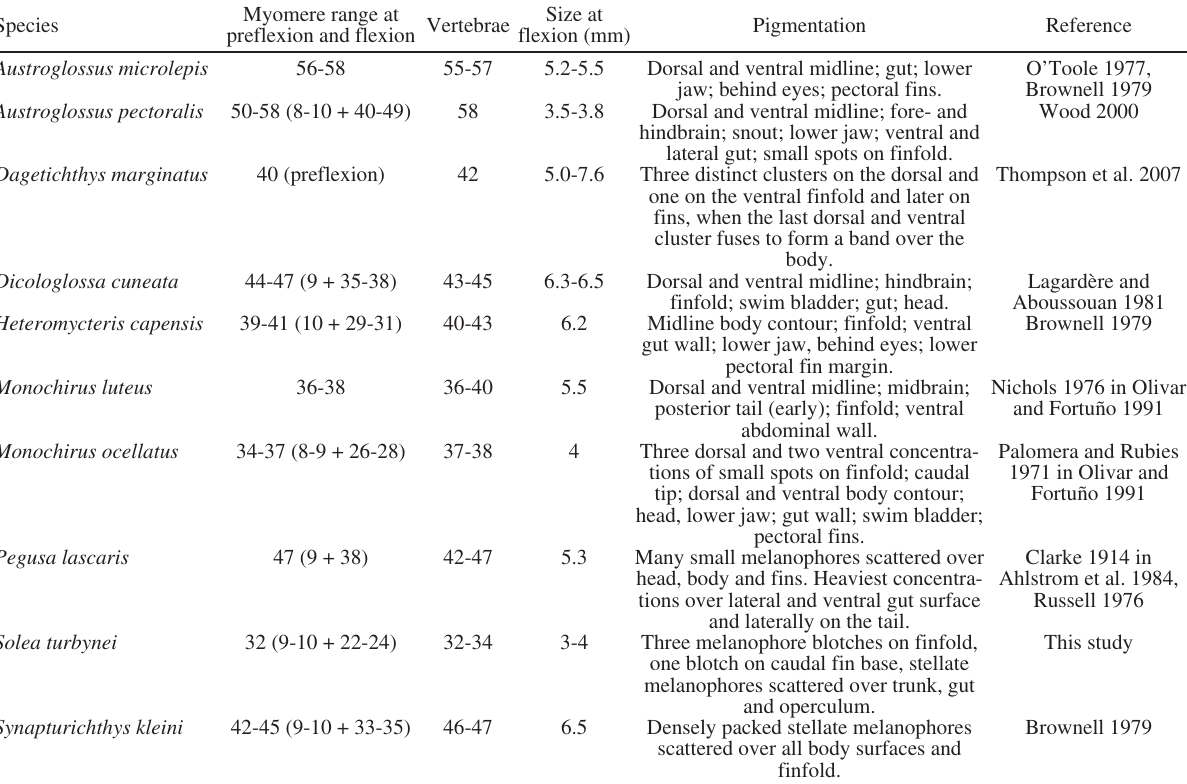
Table 2. – A list of described Pleuronectiformes larvae occurring in the Atlantic and Indian oceans off southern Africa, adapted from Wood (2000) and Thompson et al. (2007). Species